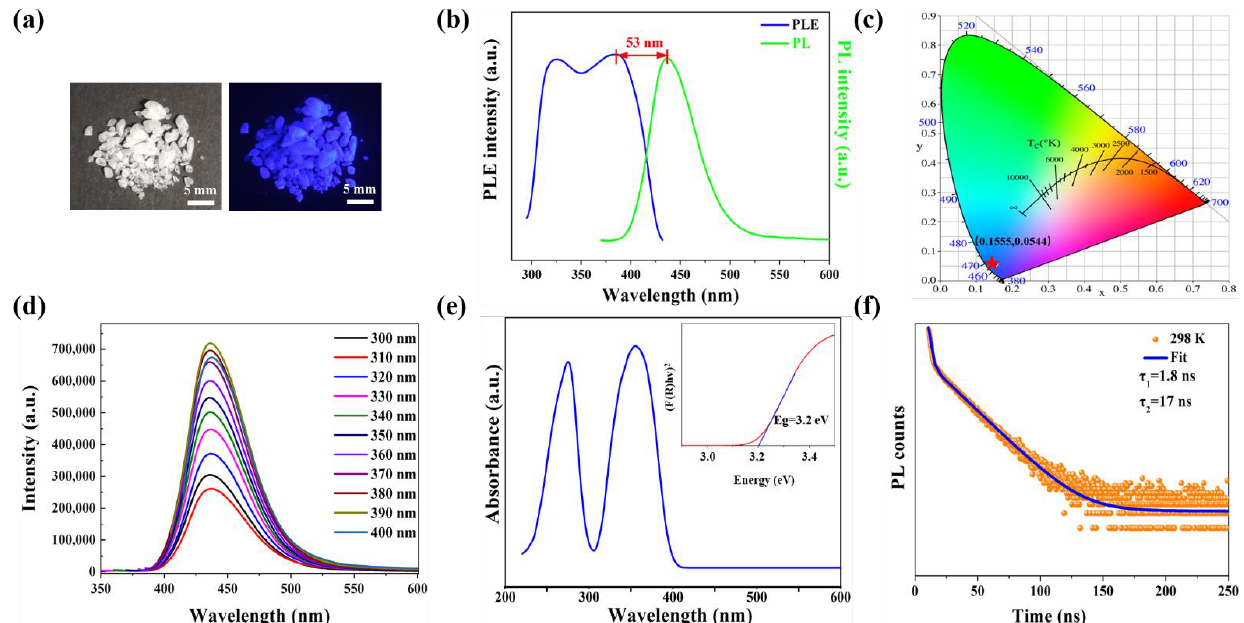
Figure 2. ( a ) Photographs of (TPA) 2 PbBr 4 SCs under daylight and 365 nm illumination. ( b ) PL and PLE spectra of (TPA) 2 PbBr 4 SCs measured at RT. ( c ) CIE color coordinates of (TPA) 2 PbBr 4 SCs. ( d ) Excitation-dependent PL spectra of (TPA) 2 PbBr 4 SCs. ( e ) Absorption spectrum, and the inset